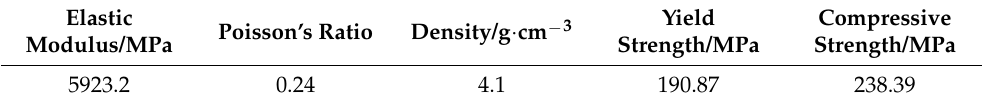
Figure 5. The compressive stress–strain curve of sprayed material without shot peening. Table 3. The mechanical property parameters of Al-Zn coating.